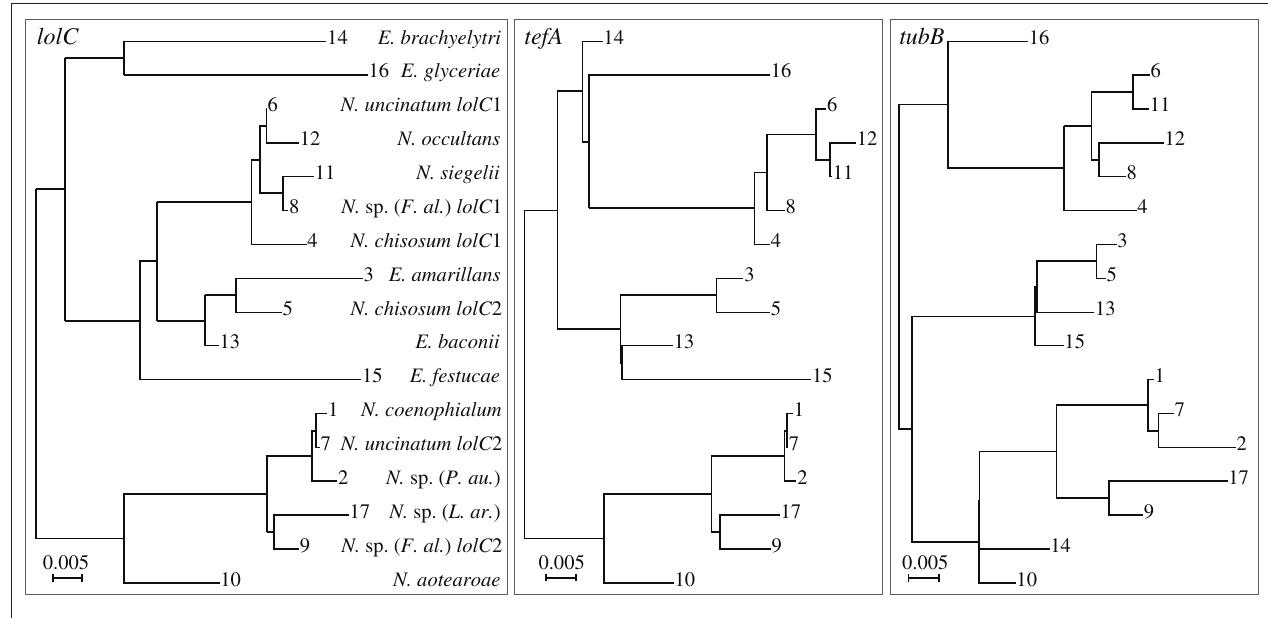
different ancestors. The genes from the different genomes are distinguished, for example, as lolC 1 and lolC 2. The same number labeling leaves on the three trees indicates genes from the same genome from the same fungal